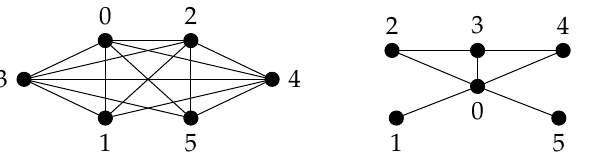
Figure 5. ( left ) T Z ( R / I ) ( Γ ( R / I )) and ( right ) T I ( Γ ( R )) , when R = Z 6 and I = ( 0 ) . ( ii ) Let I = ( 2 ) , then R / I = Z 2 (see Figure 6).